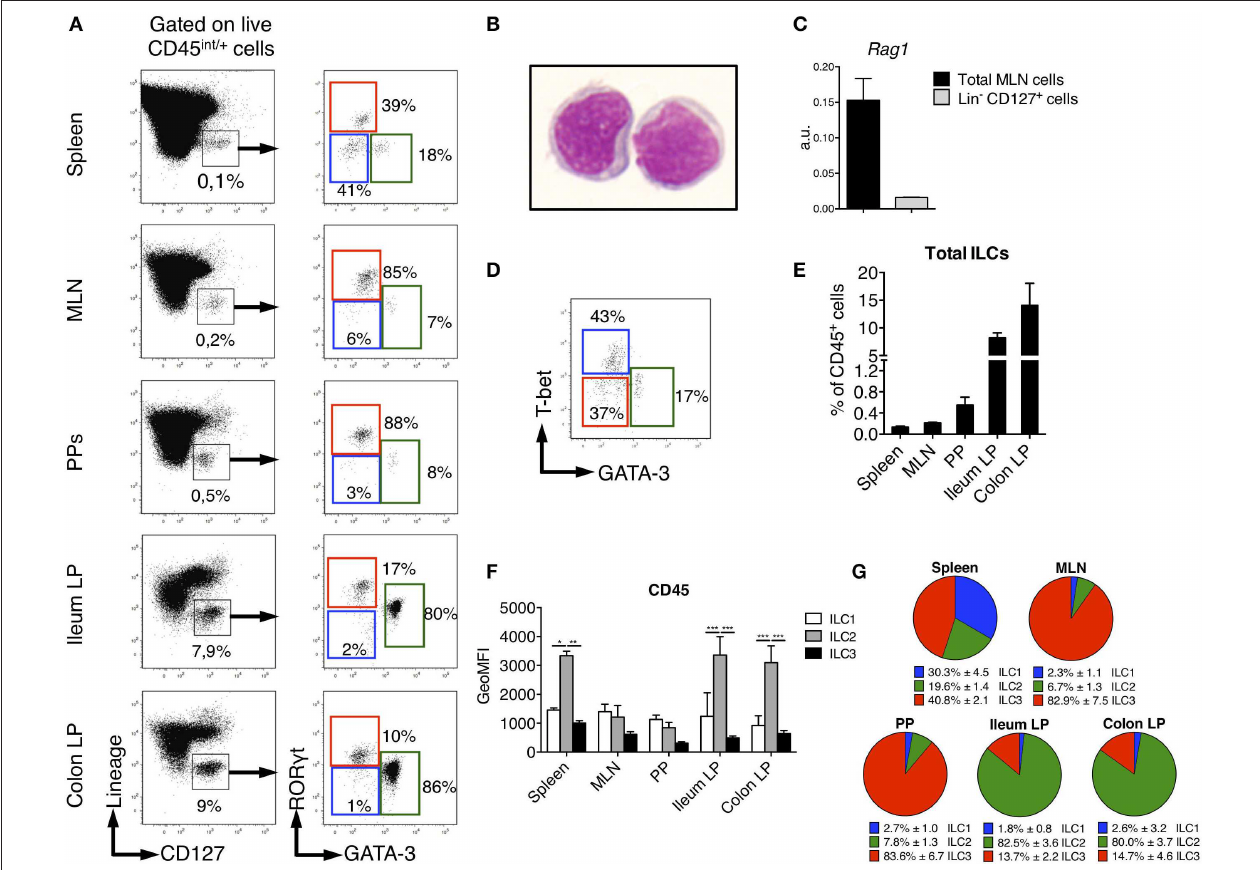
FIGURE 1 | Identification of ILC subsets in SPD Rats. To characterize ILC subsets in lymphoid and gut-associated tissues, cells were isolated from mesenteric lymph nodes (MLN), Peyer’s patches (PP), ileum and colon LP of SPD rats. (A) Representative flow cytometry plots showing the gating approach used to identify putative ILCs (Left panels) and ILC subsets (Right panels) on the basis of the expression of the transcription factors GATA-3 and ROR γ t in the depicted tissues. (B) May-Grünwald-Giemsa staining (original magnification X100) of rat Lin − CD127 + ILCs as gated in (A) that were sort-purified from MLN of SPD rats. (C) Rag1 gene expression was assessed by qPCR on total MLN cells and sorted Lin − CD127 + cells SPD rats ( n = 3). (D) Representative flow cytometric plot showing T-bet vs. GATA-3 expression in spleen ILC subsets from SPD rats. (E) Frequencies of total Lin − CD127 + ILCs expressed as percentage of CD45 + leukocytes in different tissues from SPD rats. ( n = 6). (F) CD45 mean fluorescence intensity (MFI) on ILC subsets from the depicted tissues from SPD rat. (G) Distribution of ILC subsets among total ILCs from SPD rats. n = 6 for each tissue. * p < 0.05, ** p < 0.01, *** p <